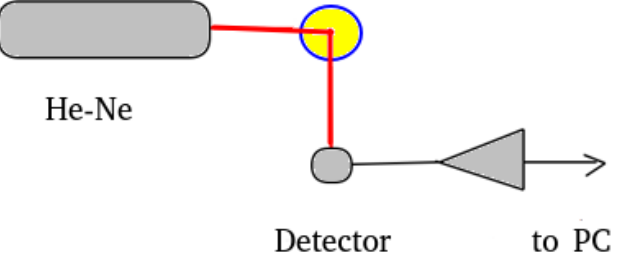
Figure 1. Dynamic light scattering (DLS) experimental setup.